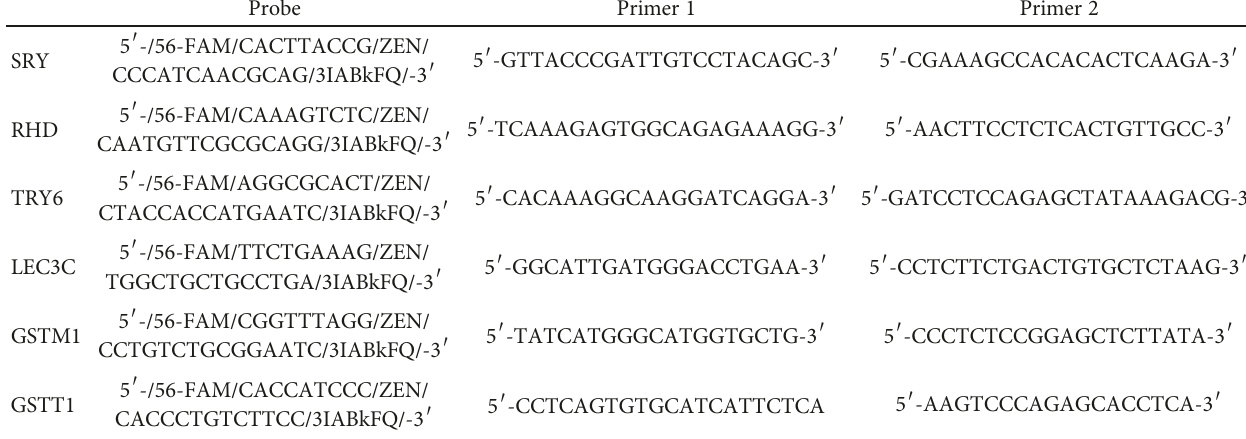
Table 2: Primers and